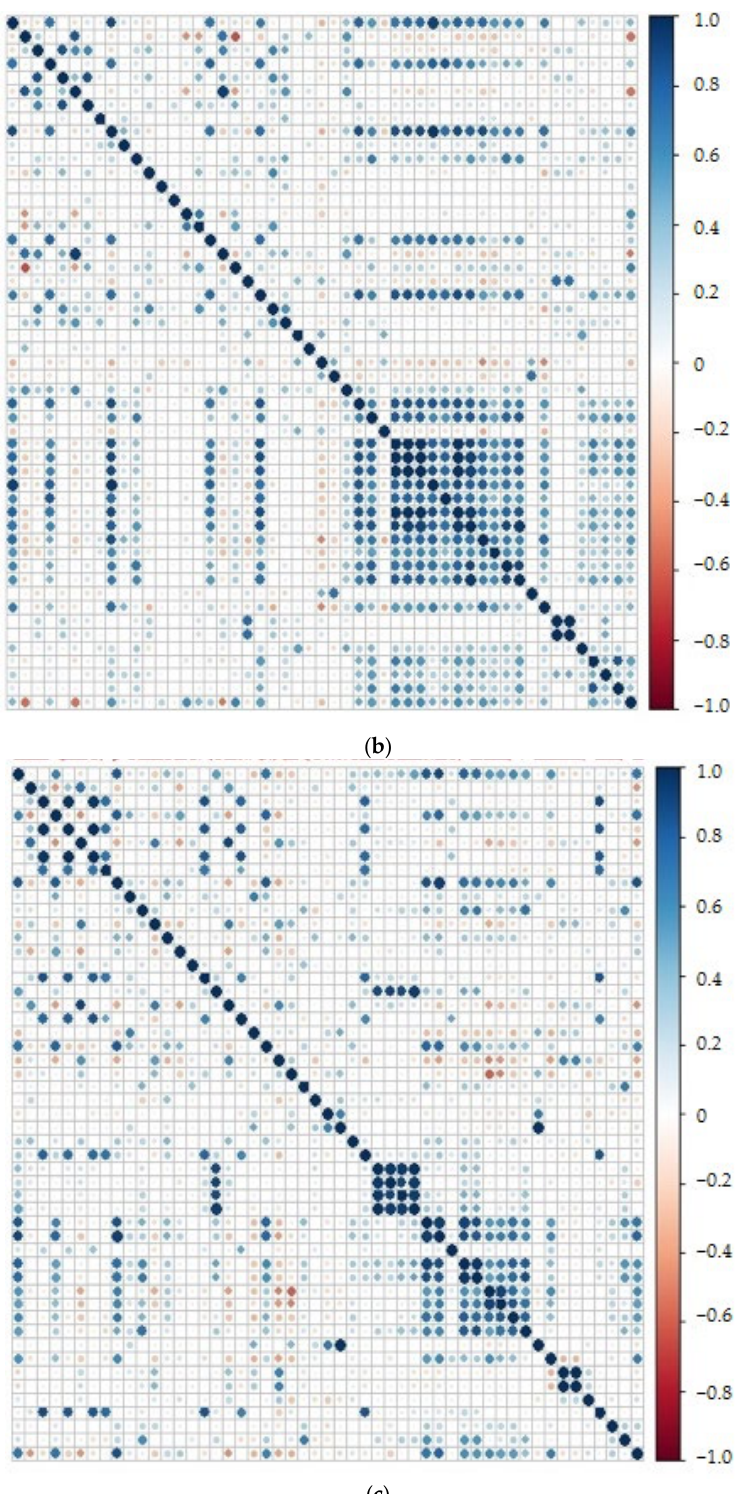
Figure 1. Spearman rank-order correlation matrices of average trace elements in the following order-Be, Na, Mg, Al, P, K, Ca, Ti, V, Cr, Mn, Fe, Co, Ni, Cu, Zn, Ga, Rb, Sr, Zr, Se, 78–94 Se, Mo, Ag, Co, Sn, Sb, Cs, Ba, La, Ce, Pr, Nd, Sm, Eu, Gd, Tb, Dy, Ho, Er, Tm, Yb, Hf, Pt, Hg 201 , Hg 202 , Tl, Pb, Bi, Th, U, quantified in the meninges: the left arachnoid ( a ), and the right arachnoid ( b ) mater, and the dura mater ( c ) of all subjects ( n =